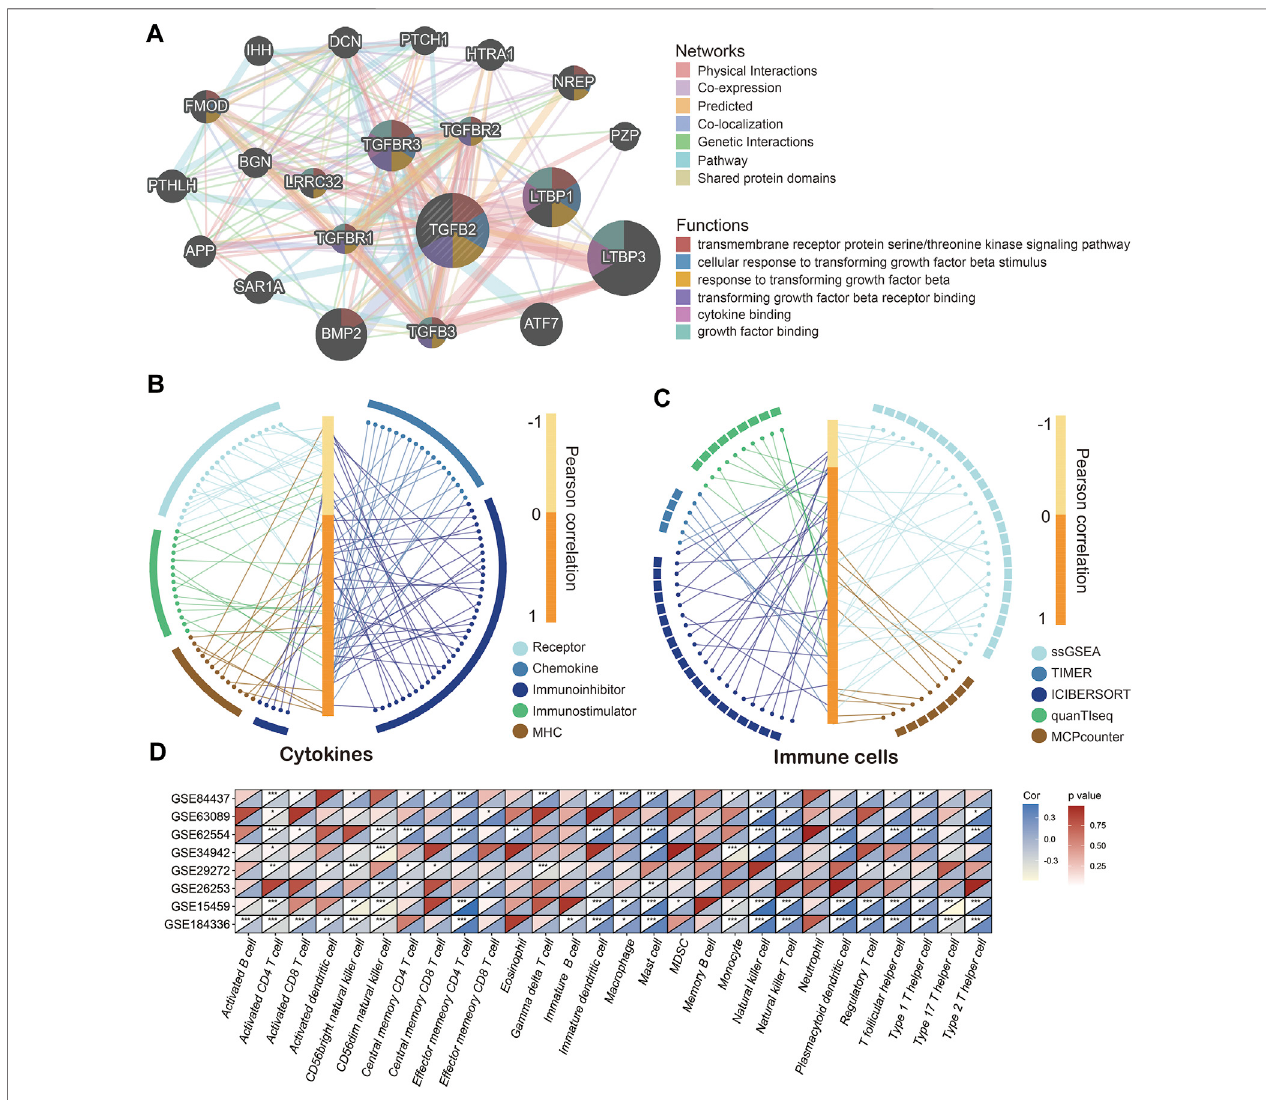
FIGURE6| TGF β 2andimmunecellin fi ltrationand cytokinelevels. (A) TGF β 2-related genenetwork.CorrelationofTGF β 2withimmunecells (B) andcytokines (C) . Correlation of TGF β 2 with immune cells in multiple GEO datasets (D) . * p < 0.05, ** p < 0.01, and *** p <